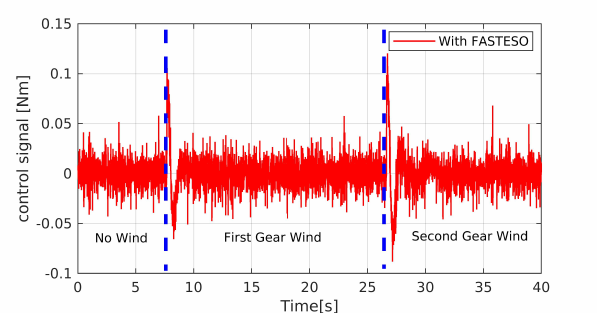
Figure 23. Control output signal only from BAC with